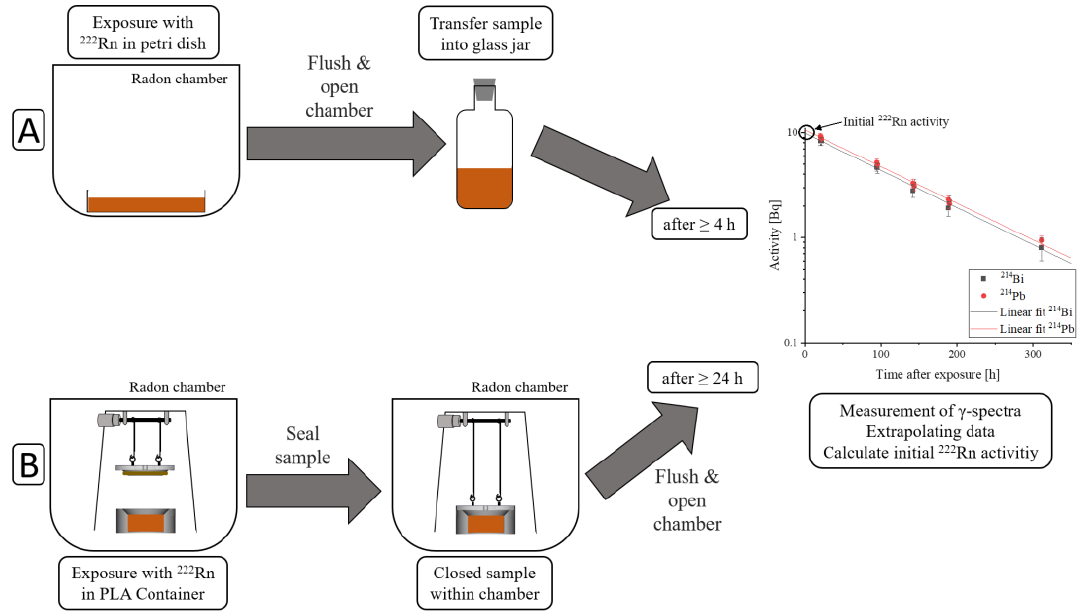
Figure 1. Comparison of the two exposure protocols. Part A describes the first, and part B the second protocol. In the first protocol, samples were exposed in the radon chamber in petri dishes to radon for 1 h at room temperature and atmospheric pressure. Afterwards, the chamber was flushed with clean air for five minutes. Then, the samples were transferred into a glass jar and sealed radon-tight. First measurements started no earlier than 4 h after sample transfer. In the second protocol, samples were exposed in a PLA-container to radon at room temperature and atmospheric pressure. After 1 h of exposure, samples were sealed within the chamber, followed by flushing the chamber. Then, 24 h later, the measurements were started, as surface contamination of the sample container had dissipated below detection limit. The measurements were carried out in the same way in both protocols; γ -spectra were recorded for a period of up to 14 d. By extrapolating the data, the initial radon activity inside the sample could be determined. Normalizing to the mass of the sample and the radon activity concentration during exposure enabled the calculation of radon solubility in the sample.